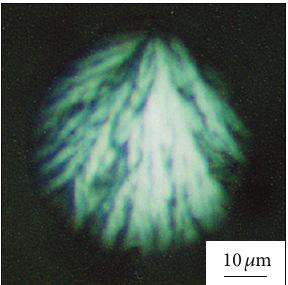
Figure4:PLMimageofspheruliteinthedropletinthefilmofinitial thickness of 43.9